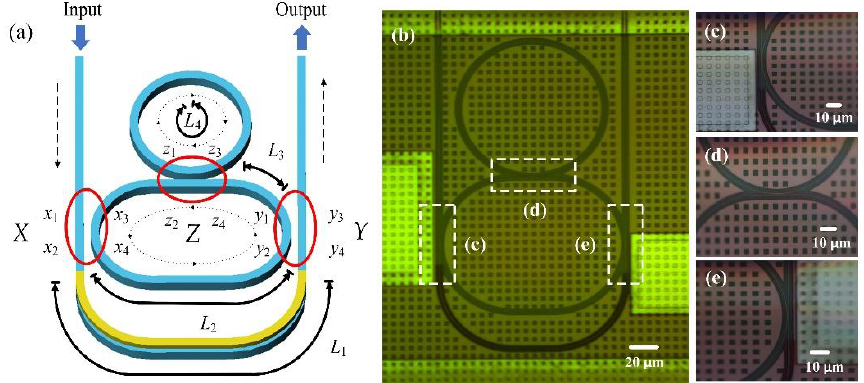
Figure 1. ( a ) Structure view of the tunable gourd-shaped ring resonator system, with dotted line for the light propagating direction. ( b ) Microscopic graph of the chip; ( c – e ) are the corresponding magnified views of dotted frame region.